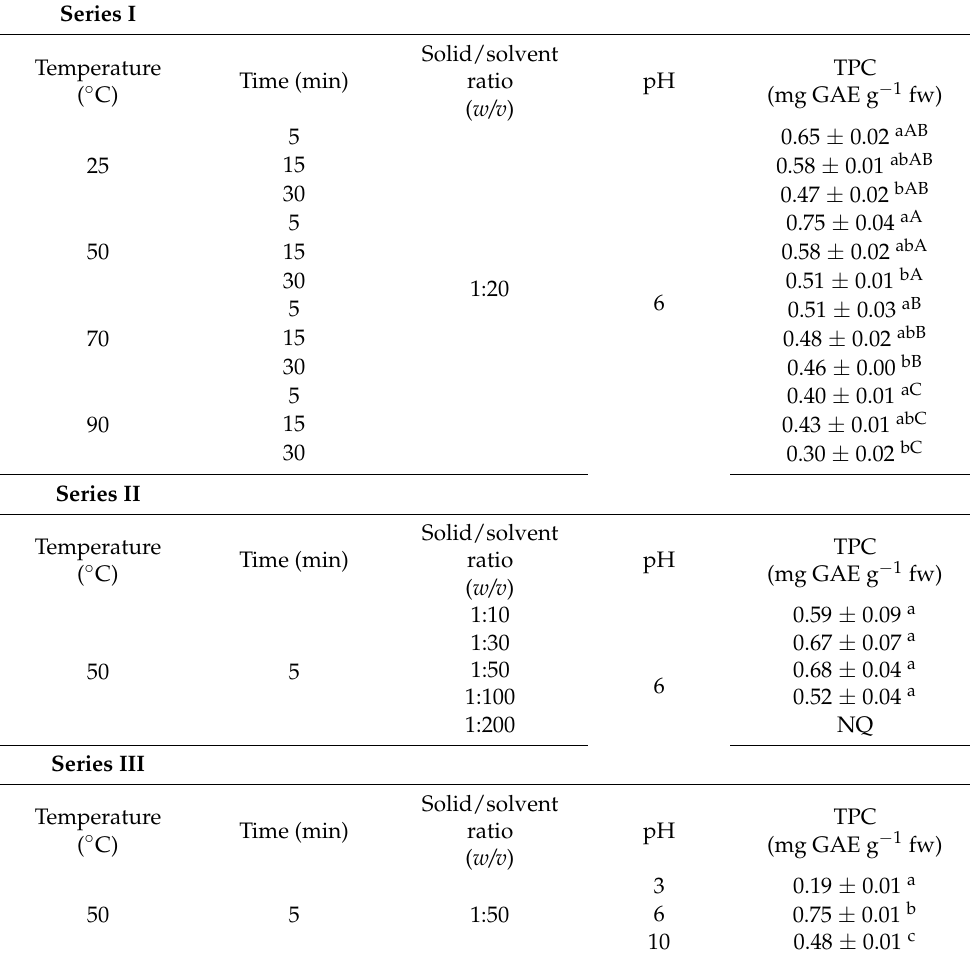
Table 2. Assessment of the influence of the experimental factors on the TPC recovery from the spinach